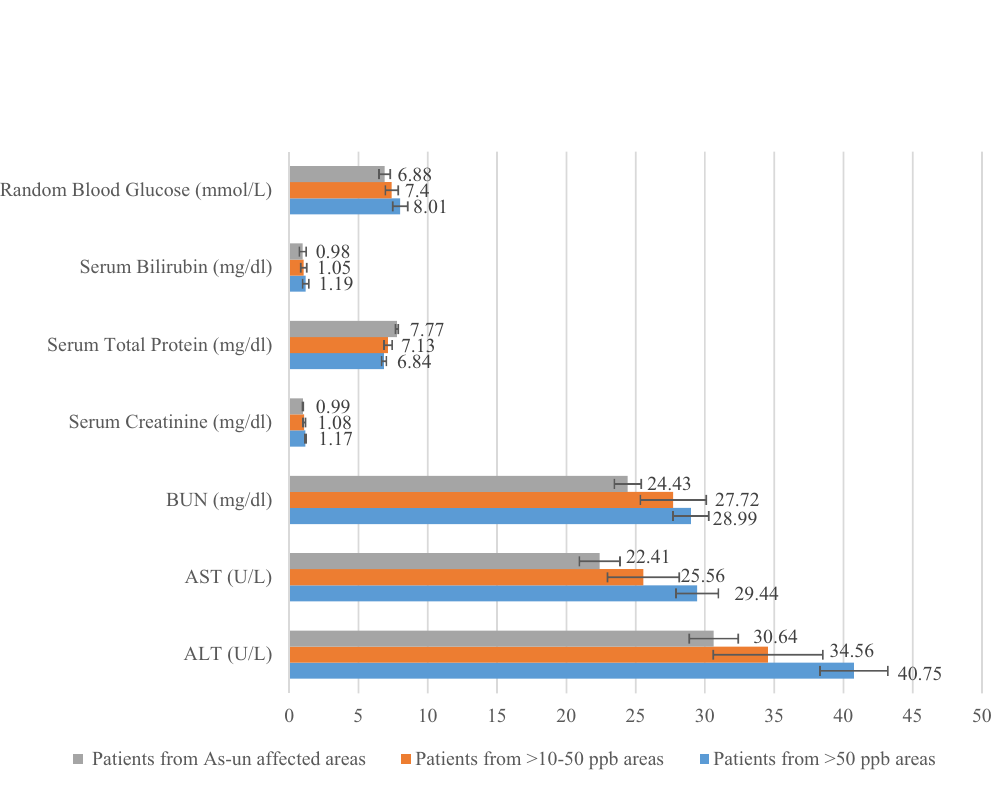
Table 5. Association of genetic polymorphism with total iAs concentration in urine, nail and cardiac tissue. The data were analyzed by Student’s t test and shown as mean ± SE value. Significant values ( P < 0.05) are typed in bold font.